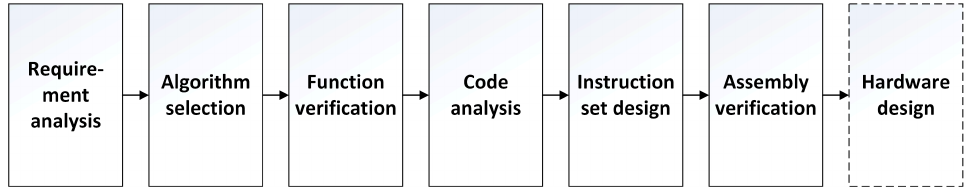
Figure 3. Flow chart of dedicated instruction set